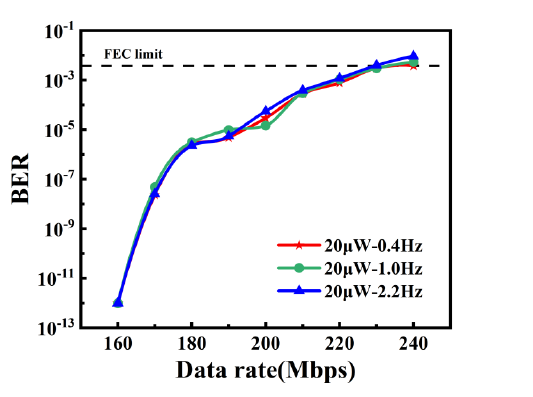
Figure 10. BER versus data rate at the different optical power frequencies and same